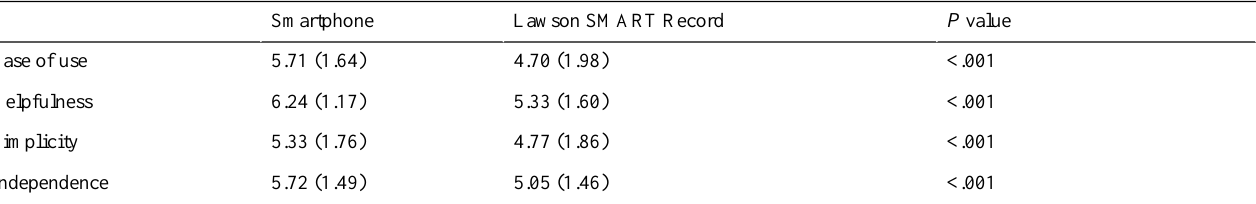
Table 3. Scores for comparison of feelings towards the smartphone and Lawson SMART Record regarding ease of use, helpfulness, simplicity, and independence they afford at 12 months post-intervention.